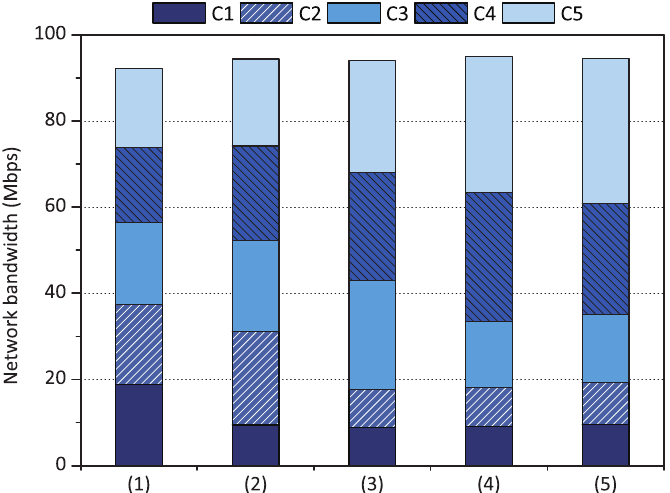
Figure 10. Maximum bandwidth limitation results of qCon when (1) proportional share scheduling was applied with weight set 1 to 1 , (2) maximum bandwidth limitation was set to [C1 = 10 Mbps] with weight set 1 to 1 , (3) [C1 and C2 = 10 Mbps] with weight set 1 to 1 , (4) [C1 and C2 = 10 Mbps, C3 = 15 Mbps] with weight set 1 to 1 , and (5) [C1 and C2 = 10 Mbps, C3 = 15 Mbps, C4 = 25 Mbps] with weight set 1 to 1